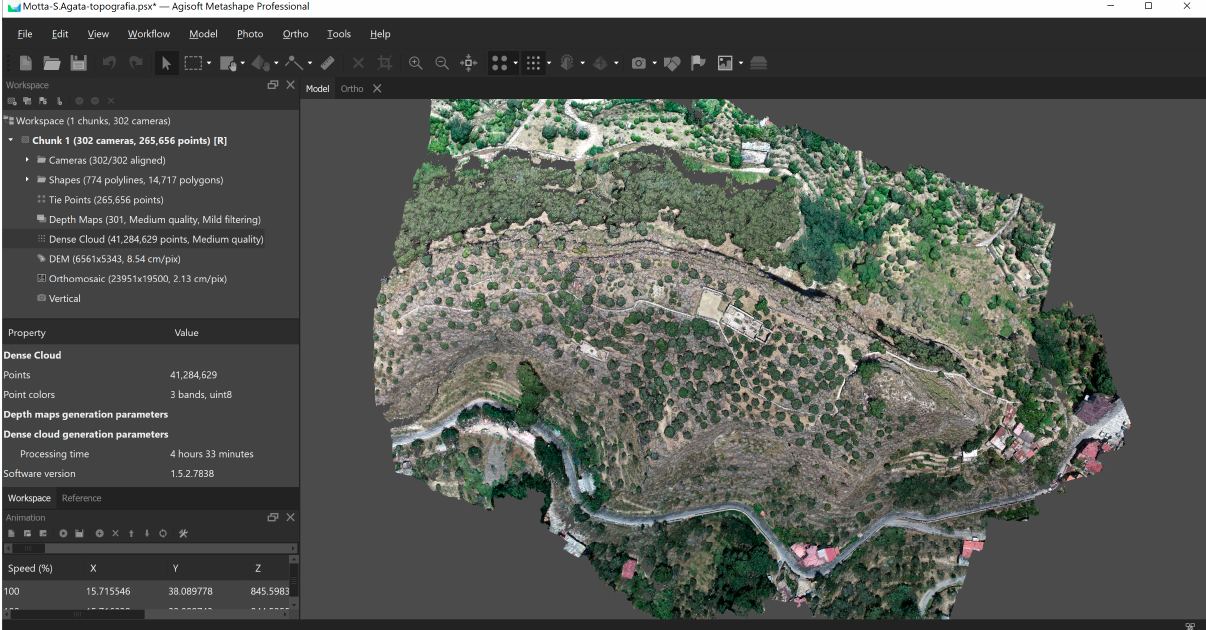
Figure 19. 3D dense cloud of the Church of San Nicola derived from UAV photogrammetry.